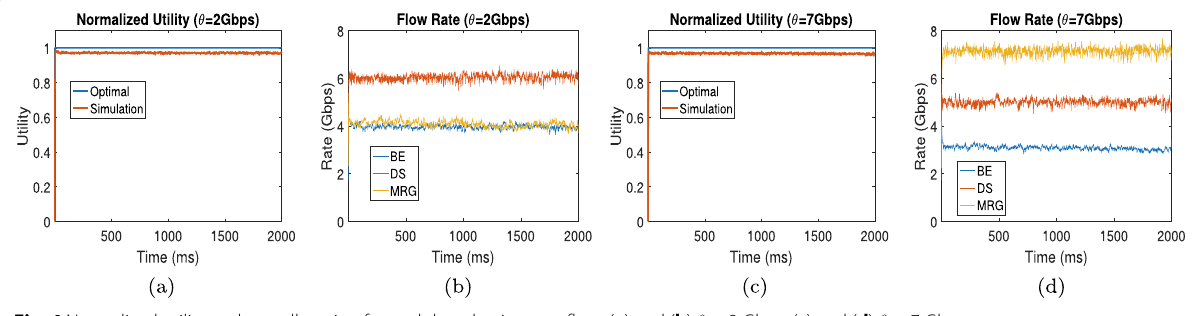
Fig. 4 Normalized utility and rate allocation for each host having one flow: ( a ) and ( b ) θ = 2 Gbps; ( c ) and ( d ) θ = 7 Gbps